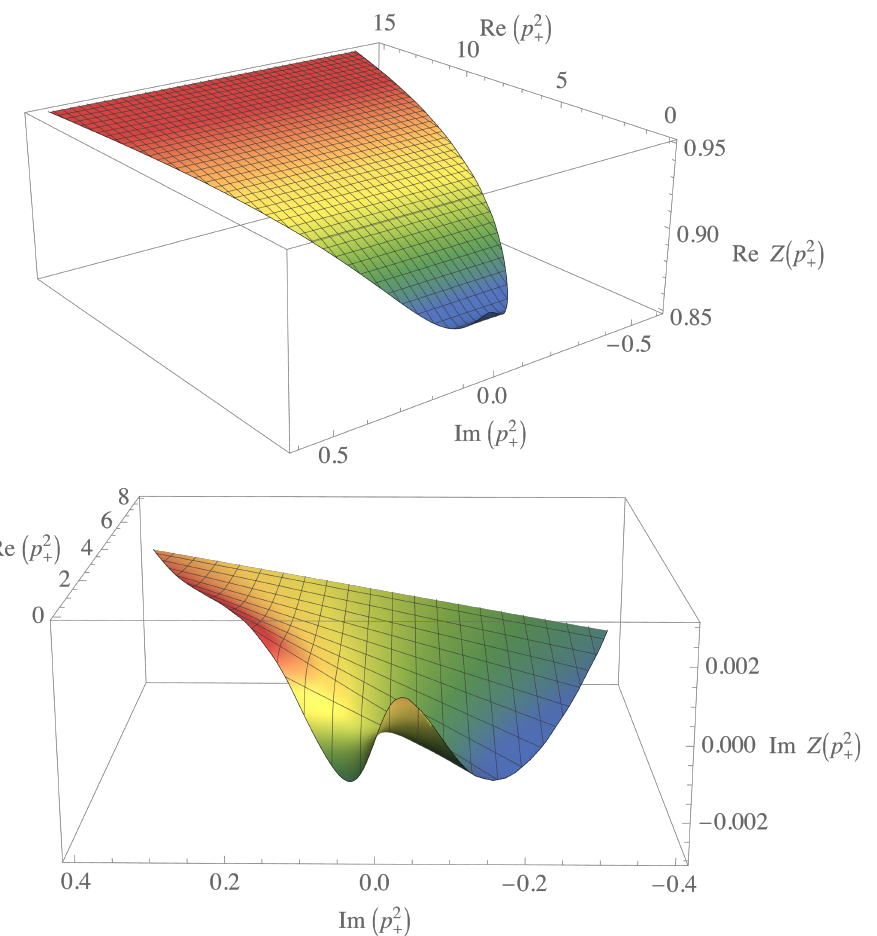
Figure 8 . Real part (upper panel) and imaginary part (lower panel) of the complex wave- renormalization function Z ( p 2 ) . Details of the DSE solution as in figure